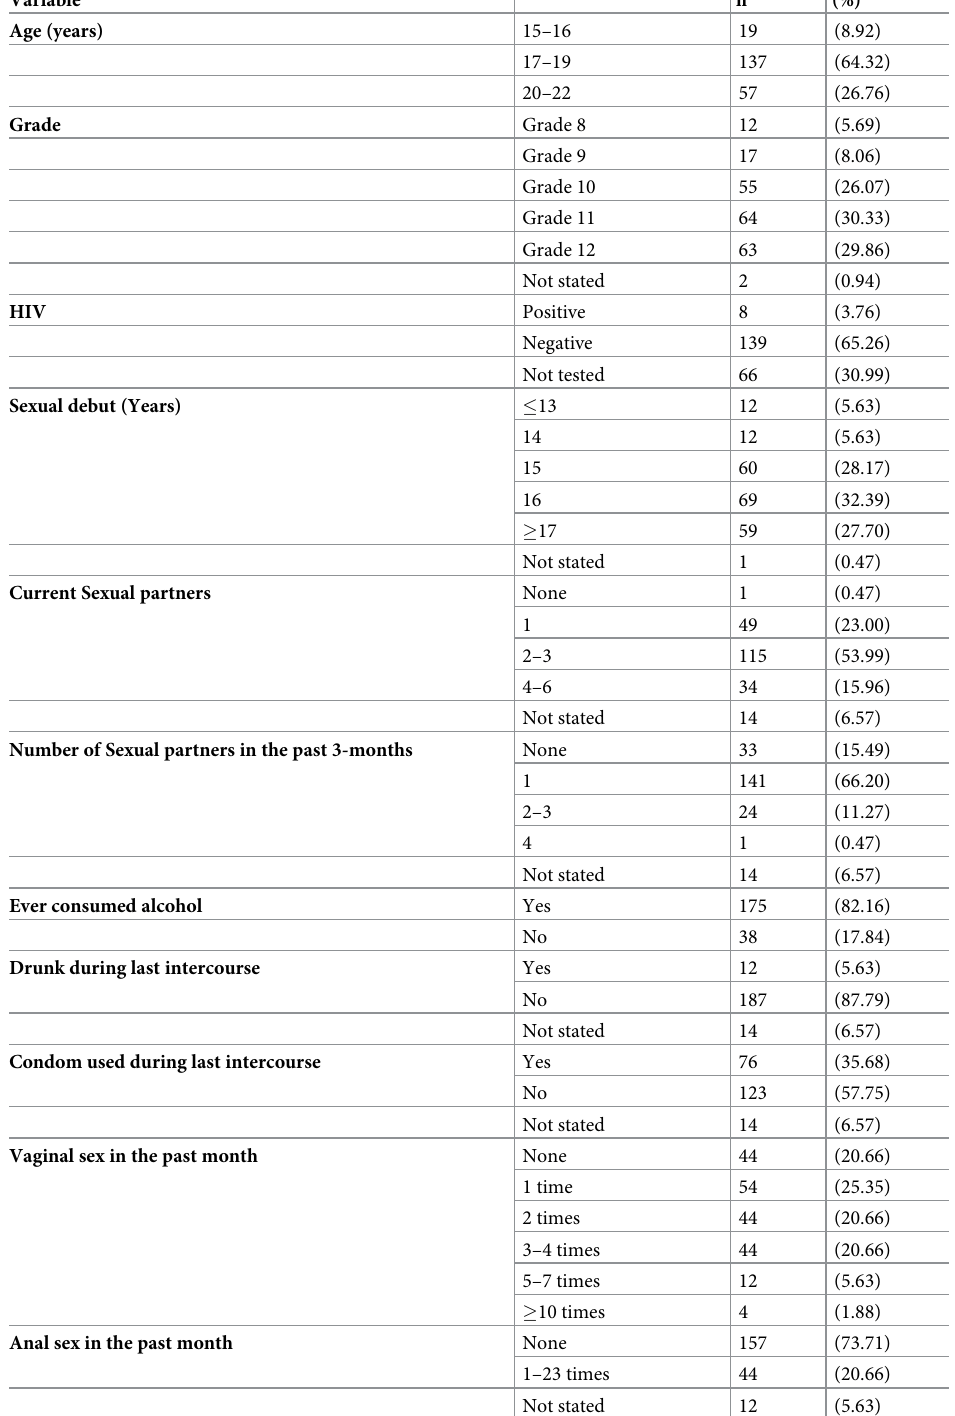
Table 2. The demographic characteristics of sexually active high school female learners who participated in the HPV prevalence study (N =